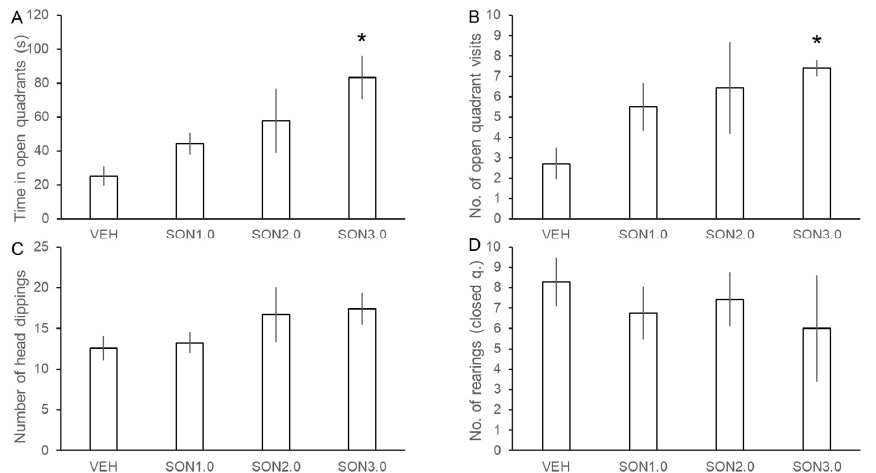
Figure 4. Effects of songorine on the behavior of rats in the elevated zero maze (EOM) test. Level of anxiety was assessed by measuring the time spent in the open quadrants ( A ), the number of visits to the open quadrants ( B ), and the number of head-dippings ( C ). As an additional variable, the number of rearings in the closed quadrants ( D ) was also counted to assess pharmacological effects of the treatments on the locomotion of the rats. Data are expressed as mean ± SEM. VEH: vehicle (3.3% DMSO), SON1.0: 1.0 mg/kg songorine, SON2.0: 2.0 mg/kg songorine, SON3.0: 3.0 mg/kg